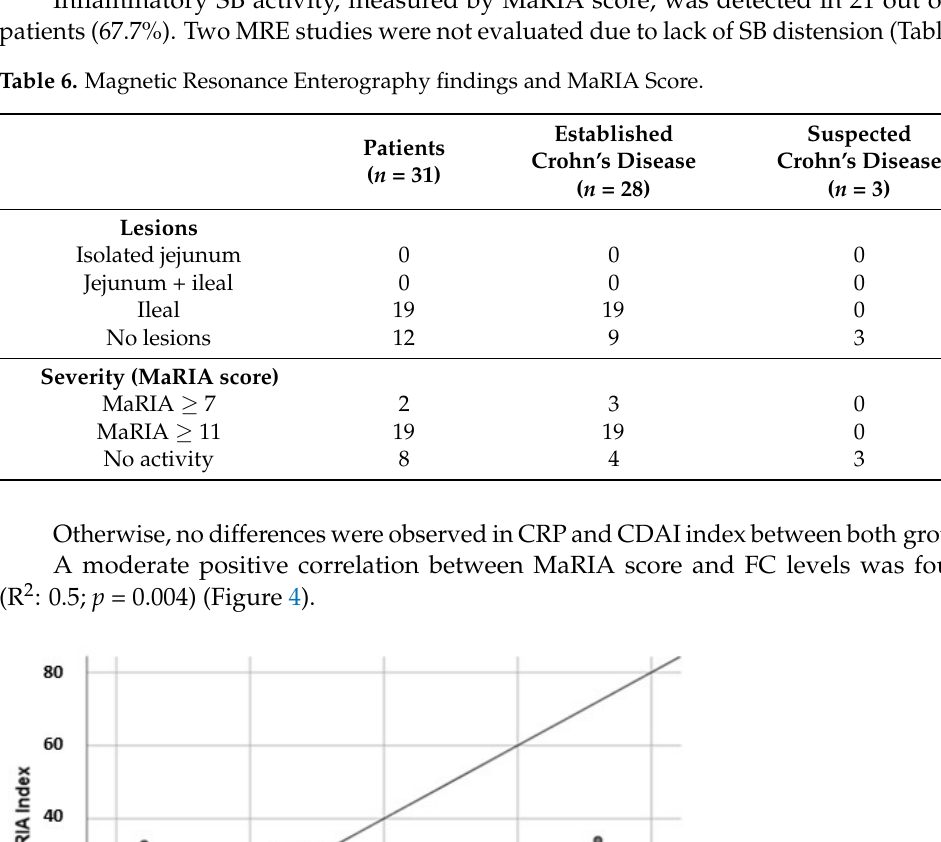
Figure 5. Receiver operating curve analysis for fecal calprotectin levels and magnetic resonance en- terography lesions. 3.3. Follow-Up Follow-up was 40.8 + 18.3 months. During this period of time, 16 (24.24%) patients presented a relapse (5 in cohort A and 11 in cohort B). A multivariate analysis was per- formed and baseline FC levels were not a predictive factor for relapse in the follow-up. 4. Discussion In this study, we analysed the correlation of SB lesions and FC in CD patients as- sessed by SBCE and MRE. A recent study of our group showed a significantly higher sen- sitivity of SBCE for detecting superficial and proximal SB lesions compared to MRE (76.6% vs. 44.7%, p = 0.001) [9]. However, MRE allows evaluation of transmural lesions and pro- vides an accurate assessment of structuring and penetrating complications, being consid- ered complementary to SBCE in the study of the SB [4,7,8,41]. The present study shows an FC cut-off higher than previously reported, in order to identify lesions in SB for SBCE and MRE (265 μ g/g and 430 μ g/g, respectively) [18–22]. Two previous meta-analyses and sys- tematic reviews studied the correlation between FC levels and inflammatory activity in the SB so far. Kopylov et al. [24] published a meta-analysis in 2016 that included seven studies (four retrospective); an FC cut-off of 50 μ g/g had a high sensitivity (83%), with low